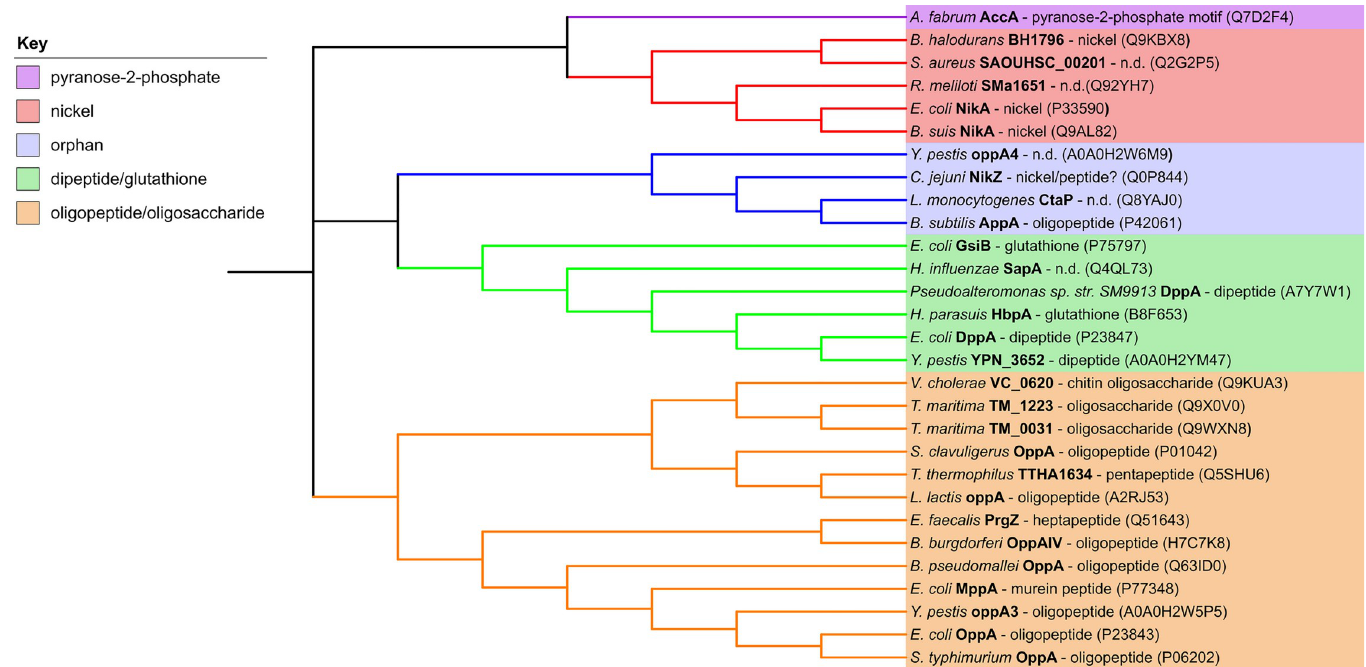
Fig 4. Cladogram of sequence relationships between structurally characterized SBP cluster C members. Clades organize by distinct functions that are colored according to the key.